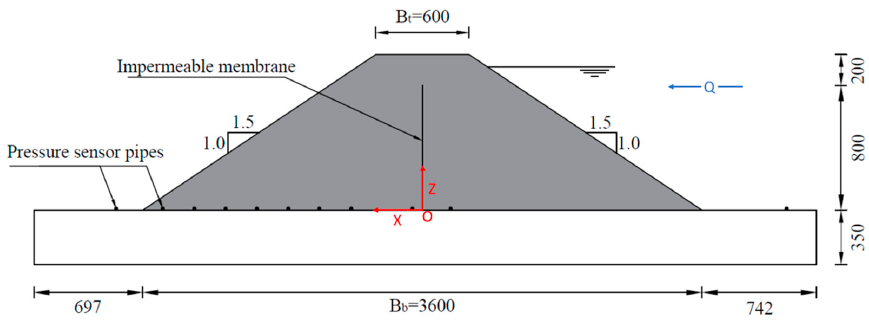
Figure 2. Model setup including core and axis system (units in mm) Y-axis out of paper plane.